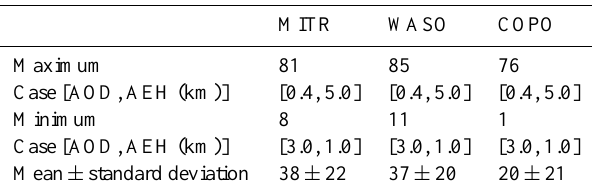
Table 4. Absolute difference of O4I for changing surface albedo by